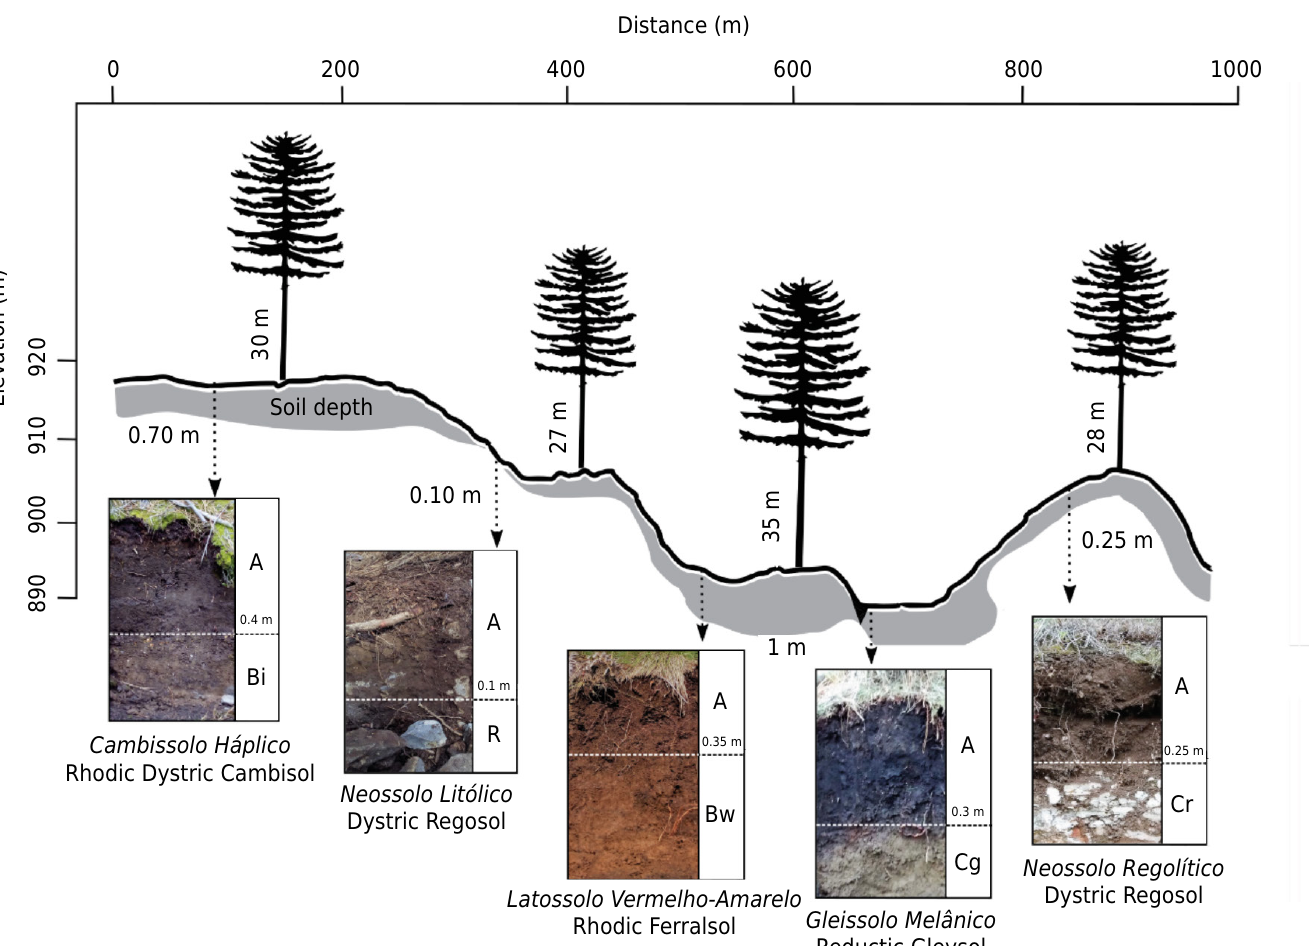
Figure 2. Relationship between soil class, soil depth and tree height of a Pinus taeda commercial plantation in a typical toposequence of the mountain region of Santa Catarina